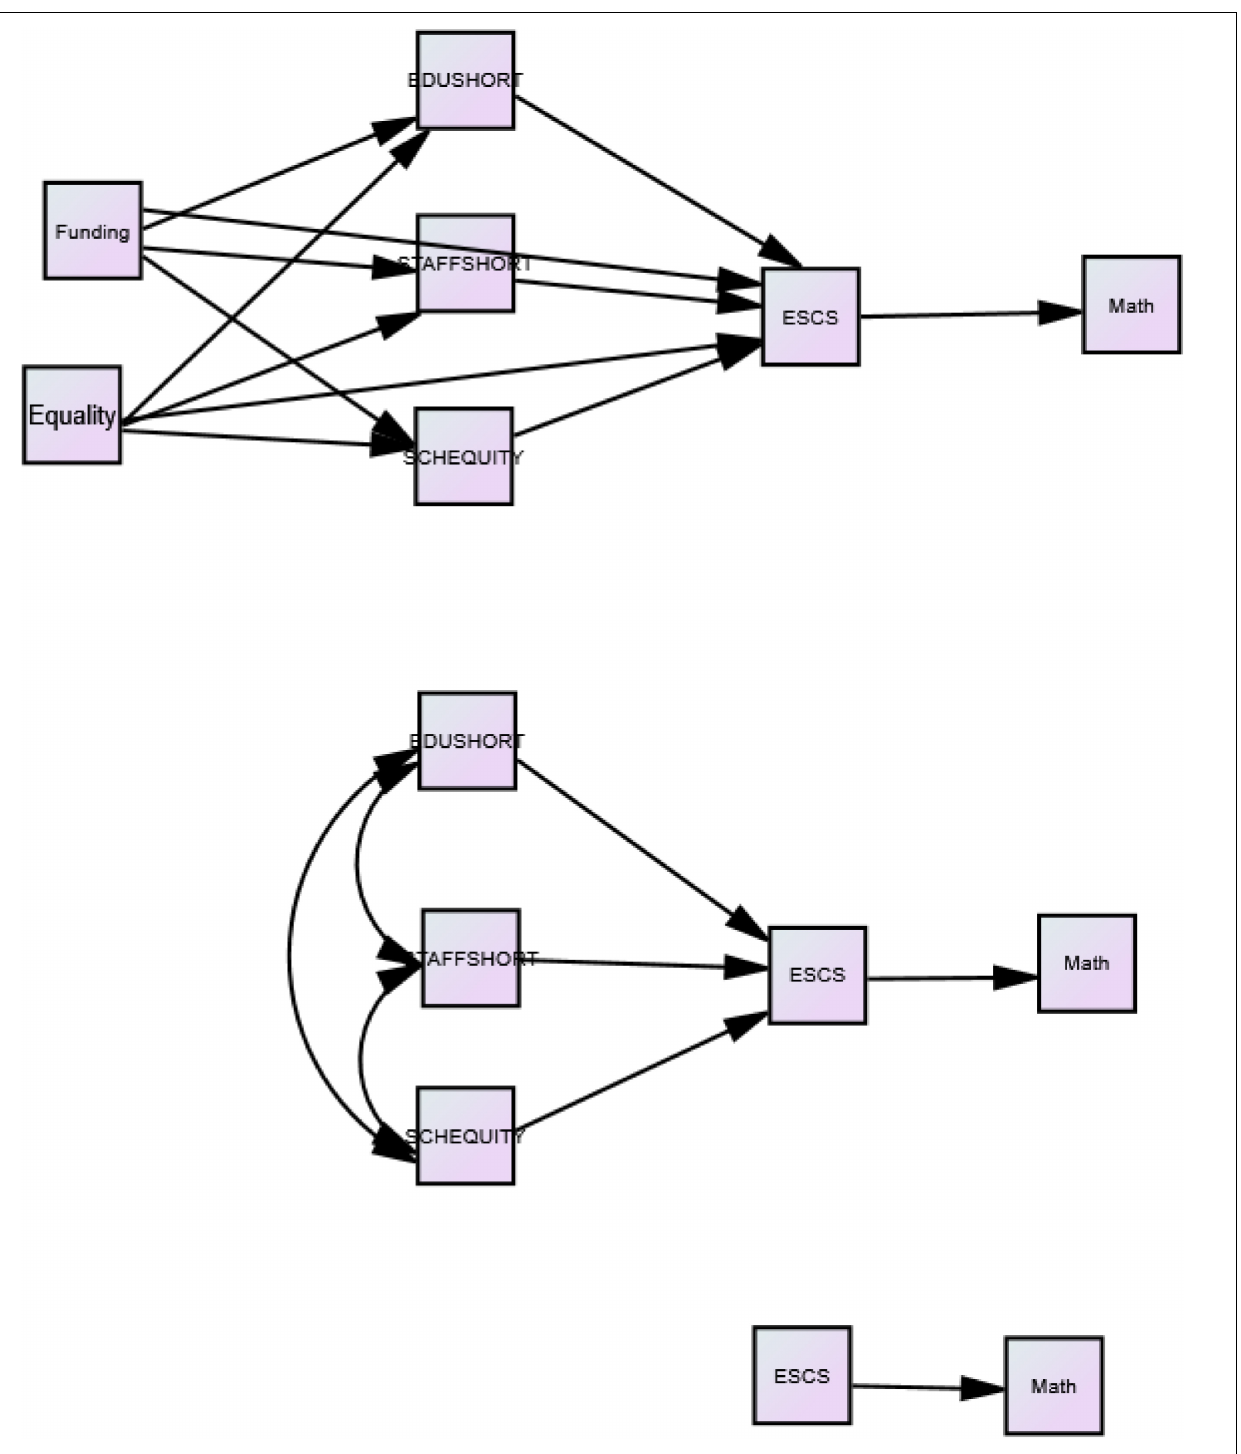
FIGURE 1 | Full mediation